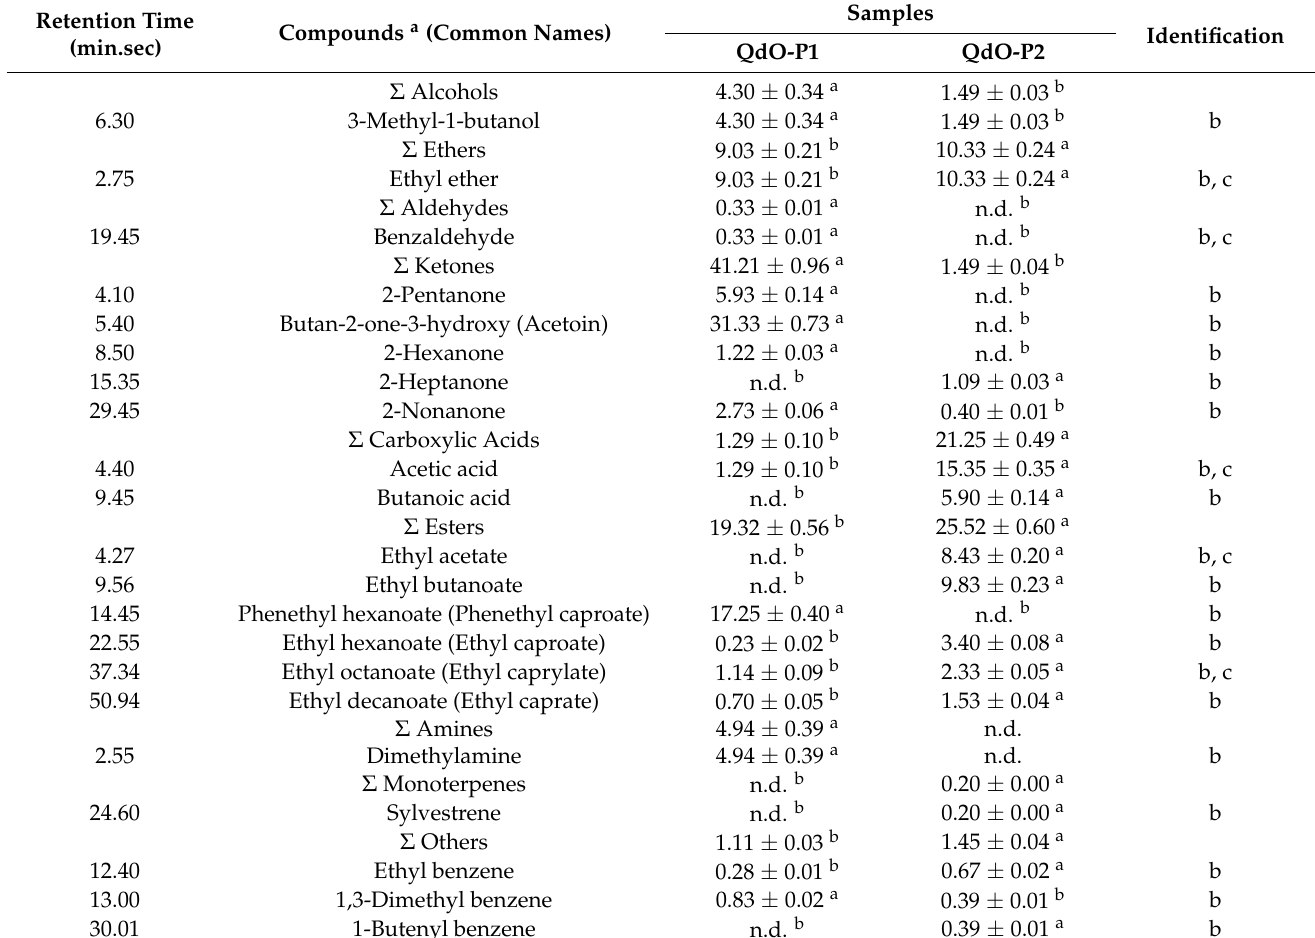
Table 5. Abundance of VOCs emitted from Quadrello di ovino